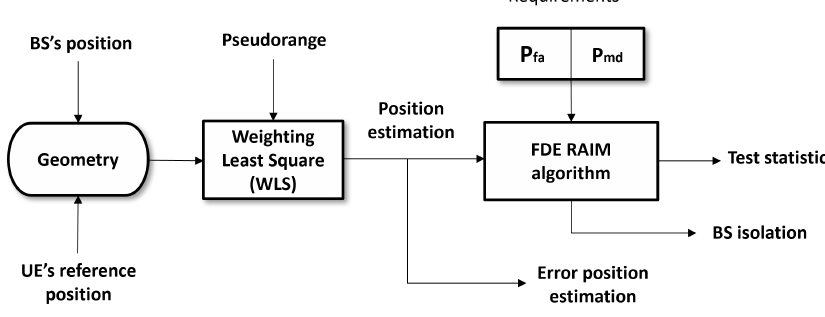
Figure 2. NLOS BS exclusion